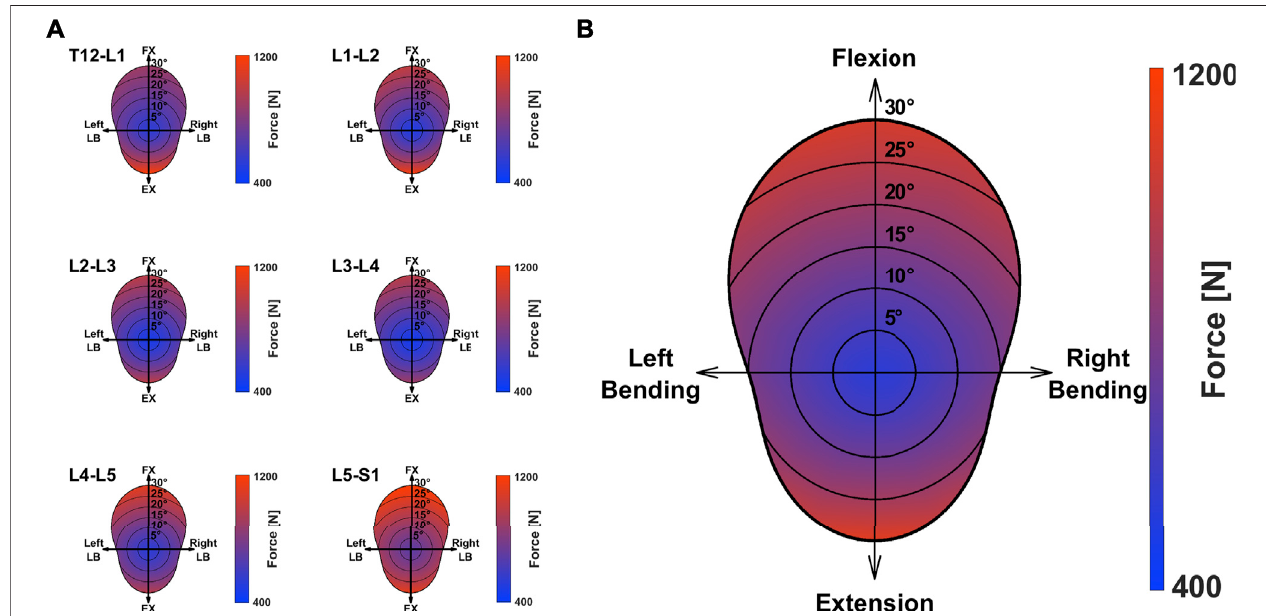
FIGURE5| MeanmagnitudeofJRFduringmovementaroundtheaxesperpendiculartothecaudo-cranialaxis.Valuesforthesinglesegments (A) andtheaverage loading over all considered joints (B) are depicted. FX: Flexion; EX: Extension; LB: Lateral Bending.